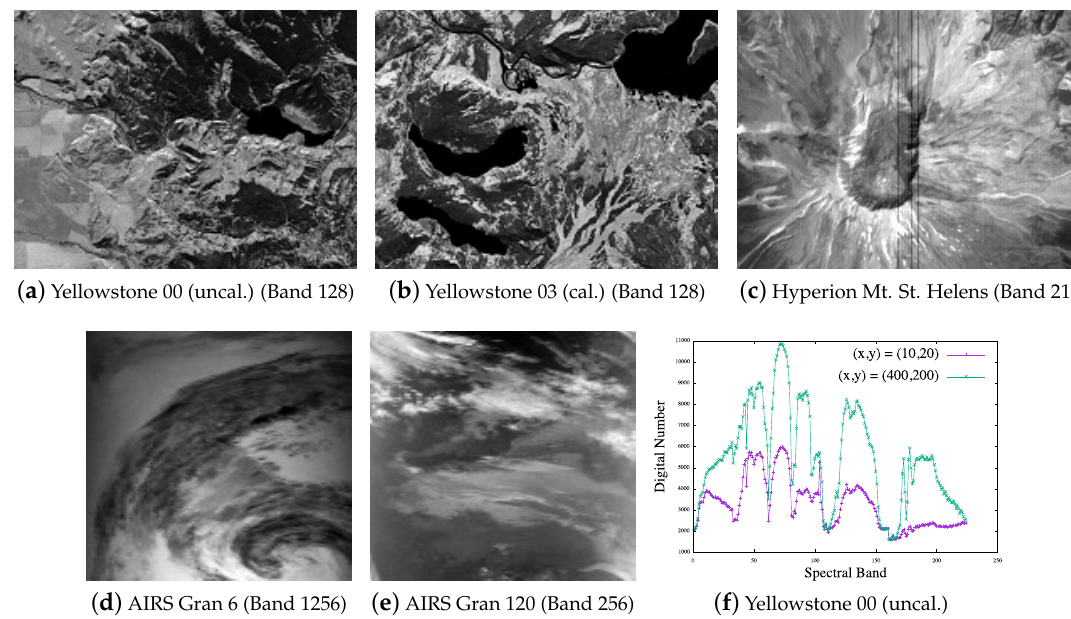
Figure 1. Several hyperspectral scenes used in this paper. The original and the decompressed scenes discussed in this paper are numerically identical. Depicted also are two spectral signatures for AVIRIS Yellowstone 00 (uncal.). The AVIRIS images in this figure are courtesy of